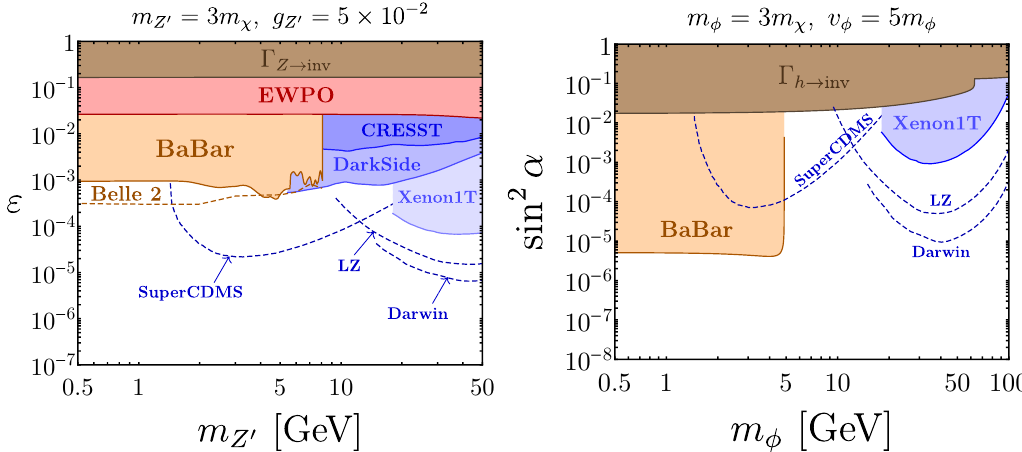
Figure 4 . Constraints on the mixings " between Z 0 and SM hypercharge and (cid:11) between the new scalar (cid:30) and the Higgs from Invible decays of Z and h , BaBar, ElectroWeak Precision Observables (EWPO) and current direct detection experiments (CRESST, DarkSide, Xenon1T) as well as sensi- tivity estimation from Belle 2 and future direct detection experiments (SuperCDMS, LZ, Darwin). All the constraints represented in this (cid:12)gure are detailed in section